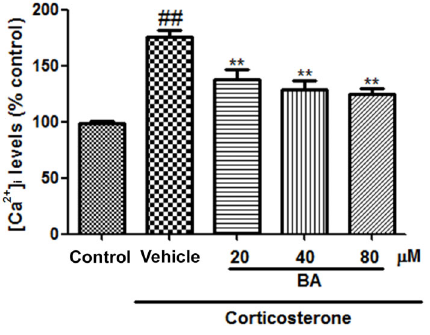
Figure 7. Baicalin (BA) reduced [Ca 2 + ] i levels in corticosterone- treated PC12 cells. Data are reported as means ± SE (n=8). ## P o 0.01 vs control; **P o 0.01 vs vehicle (ANOVA).